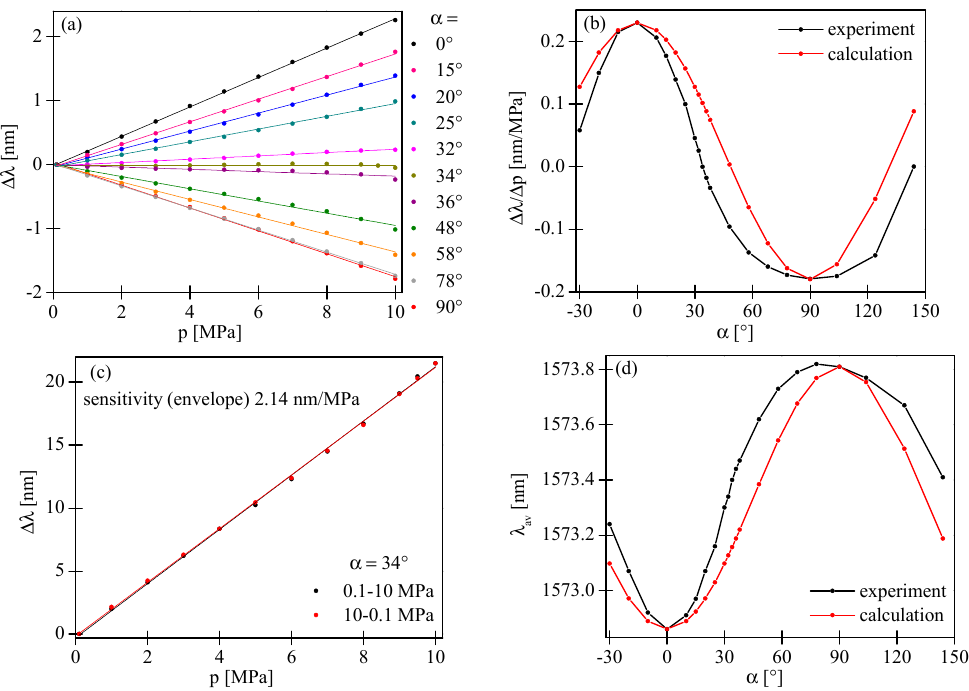
Figure 8. Displacement of the intermodal interference fringe with an intensity minimum close to 1563 nm versus the applied pressure for different azimuths of the input polarization state ( a ) and a comparison of the experimental and theoretical value of the sensitivity to pressure upon the azimuth of the input polarization state ( b ). Displacement of the envelope versus applied pressure ( c ) and experimental and theoretical dependence of the position of the interference minimum at zero pressure and the intermodal sensitivity to pressure upon the azimuth of the input polarization state ( d ).